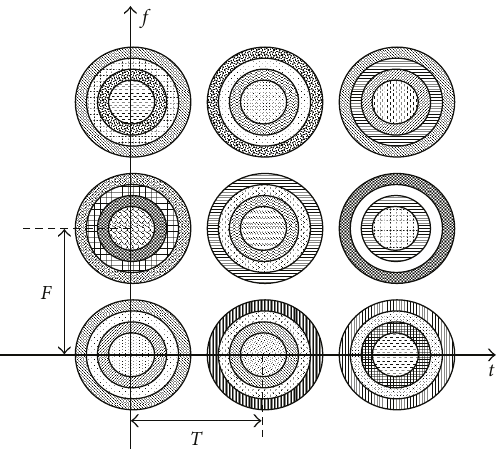
Figure 4: Toroidal-rectangular OFDM lattice structure. Here, F: frequency shift, T: time